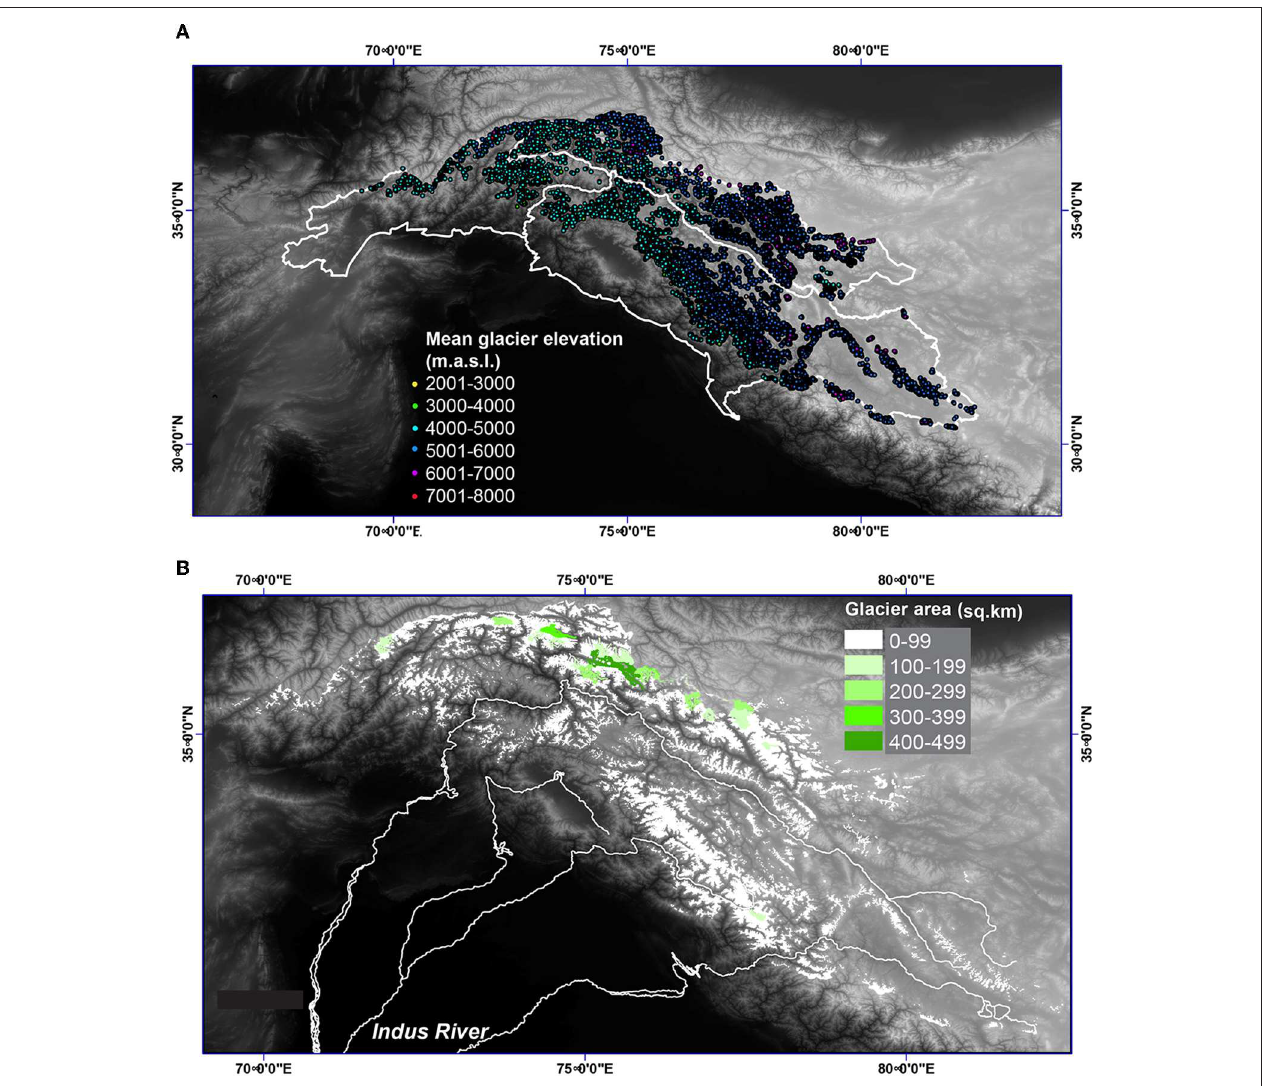
FIGURE 2 | (A) Spatial distribution of mean glacier elevation (in meters above sea level). (B) spatial distribution of glacier size (surface area, in km 2 ) across the Indus watershed.